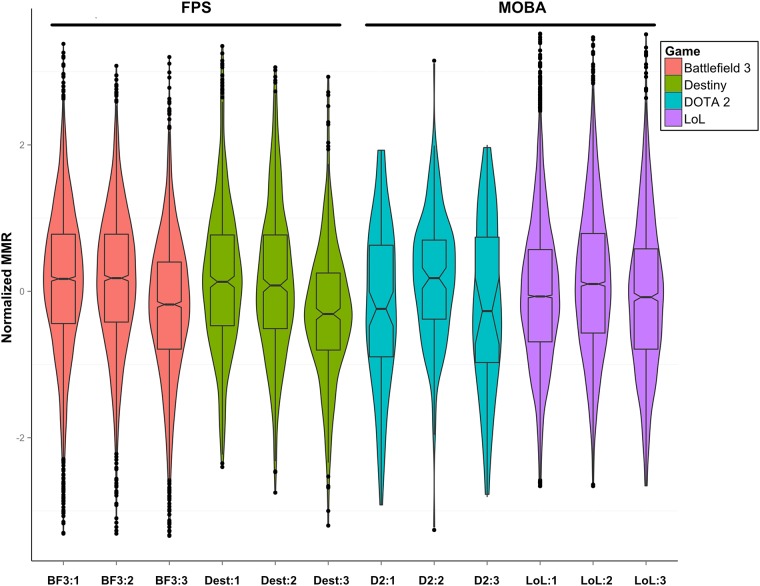
Age profiles of MMR in four different games.Three age groups for each game are plotted: (1) 13–21, (2) 22–27 and (3) 28 years an over. In two popular ‘First Person Shooter’ games (Battlefield 3 and Destiny), performance decreases monotonically with age following a ‘high, high, low’ profile. In comparison, two of the most popular multiplayer online battle arena (MOBA) games exhibit a ‘low, high, low’ profile suggesting that performance peaks in the mid-20s. Distributions whose boxplot notches do not overlap are different at p < .05.